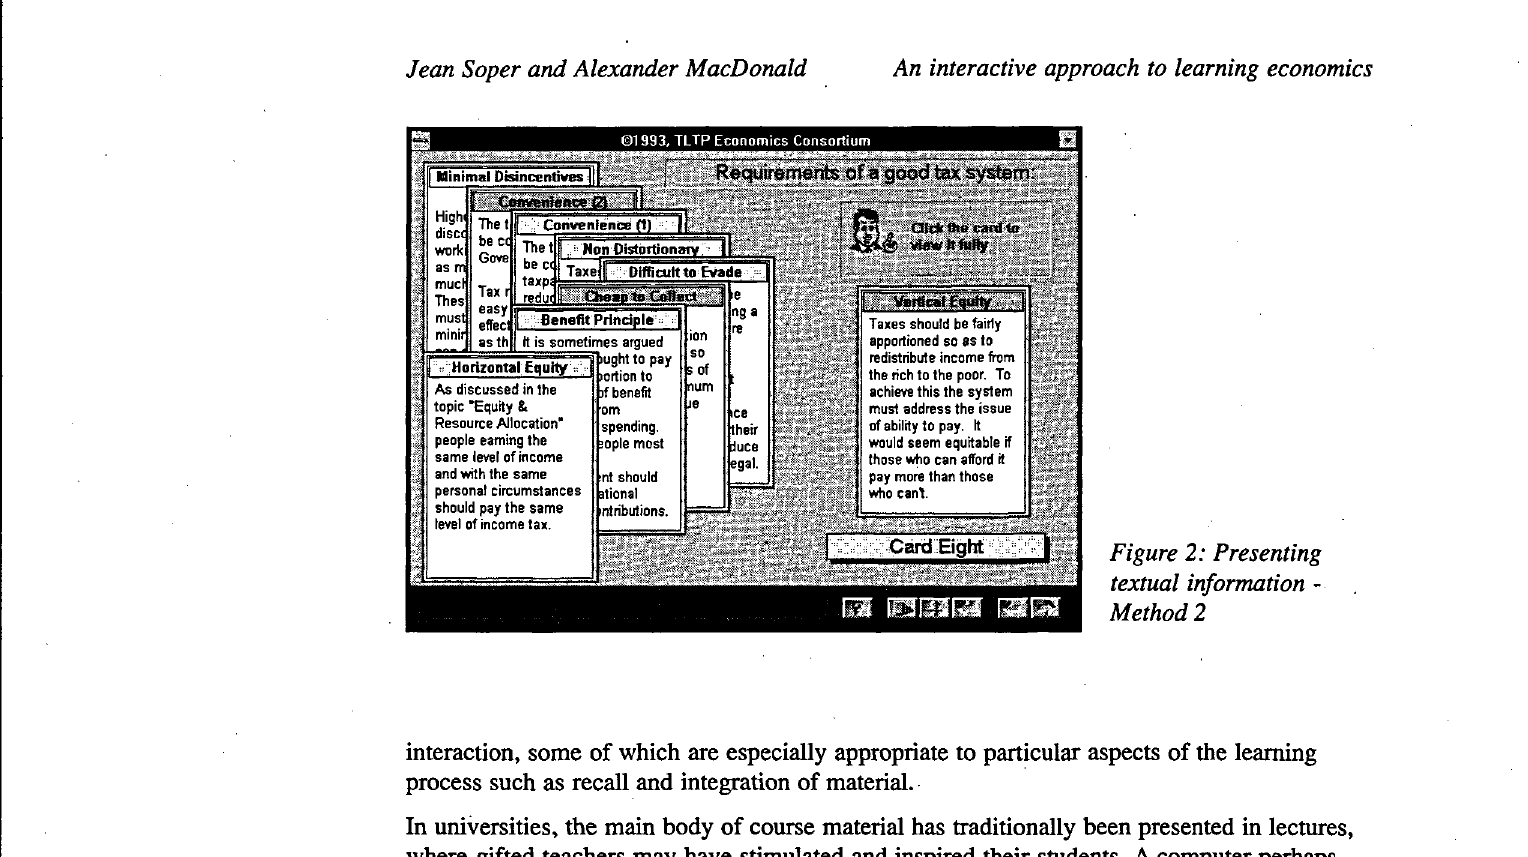
Figure 2: Presenting textual information